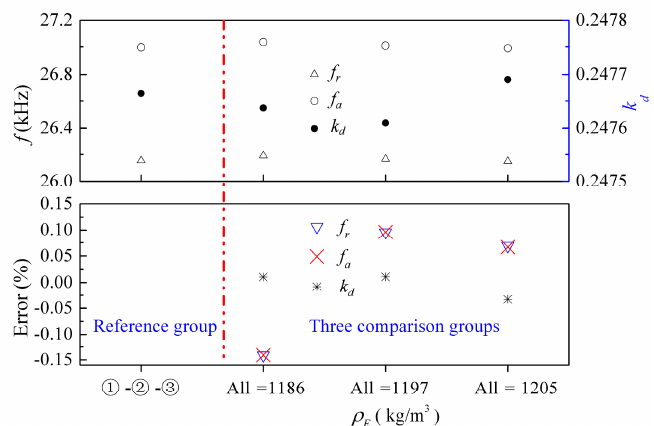
Figure 7. Influence of density of the epoxy layers on the electromechanical characteristics of the transducer. Error = (Reference group − Comparison group)/Reference group.